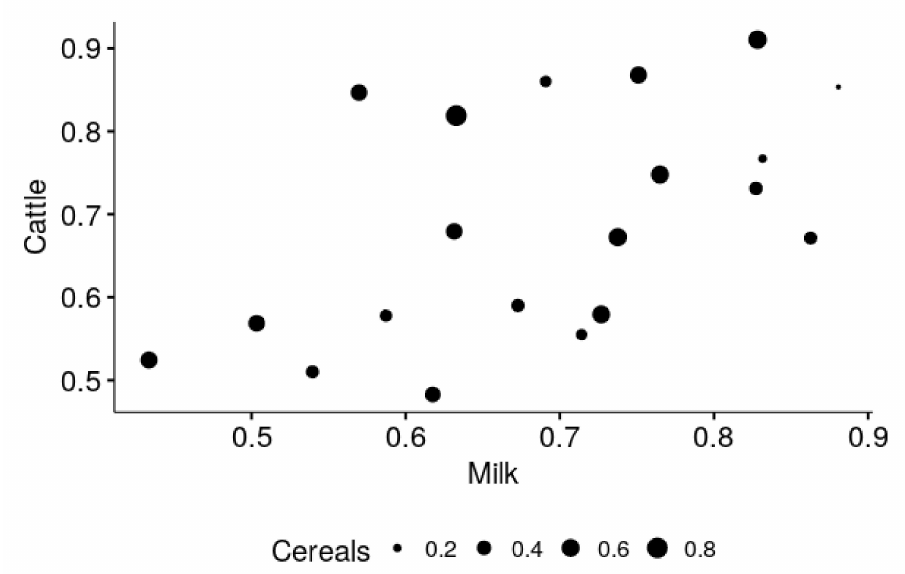
Figure 8. Environmental efficiency for farms with multiple product groups. Only farms, which have the three product groups “Milk”, “Cattle”, “Cereals” simultaneously (N = 20) were considered as Mixed farms. The figure shows the relationship between environmental efficiencies for the three product groups if they appear simultaneously on the same farm. The x -axis shows the environmental efficiency values for Milk, the y -axis the values for Cattle, and the size the values for Cereals respec- tively. The environmental efficiency for the three product groups shows no significant correlation (see Appendix A, Table